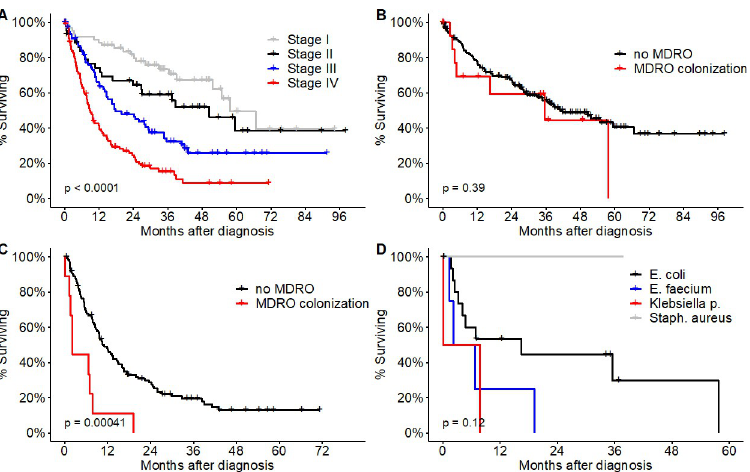
Fig 2. Competing risks analysis for death. (A) Cumulative incidence functions for relapse mortality, non-relapse mortality, or mortality not otherwise specified (unknown) of all patients. (B) Cumulative incidence functions of patients stratified by multidrug-resistant organism (MDRO) colonization. Competing risks regression model [35] was used to calculate p values for differences in non-relapse mortality (p < 0.00001) and relapse mortality (p = 0.49) between patients colonized by MDRO and patients without MDRO.